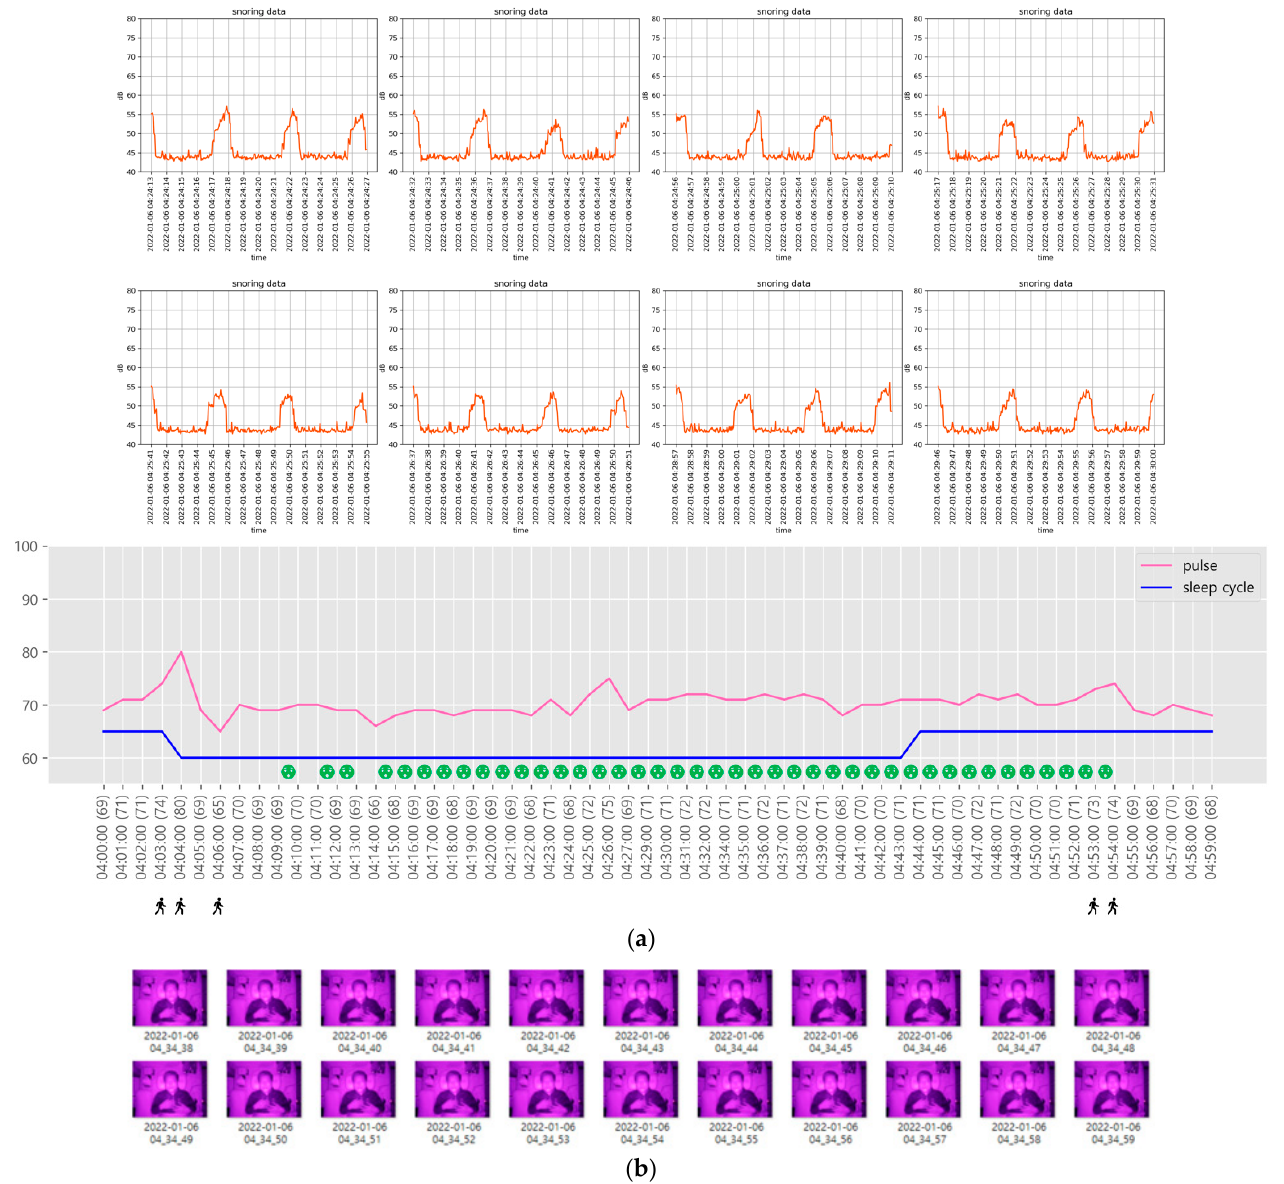
Figure 19. Sleep-related information in the section predicted by the NREM sleep stage . ( a ) Sleep- related information during the predicted NREM sleep stage; ( b ) 22 snapshots of sleep postures captured from 04:34:38 to 04:34:59.